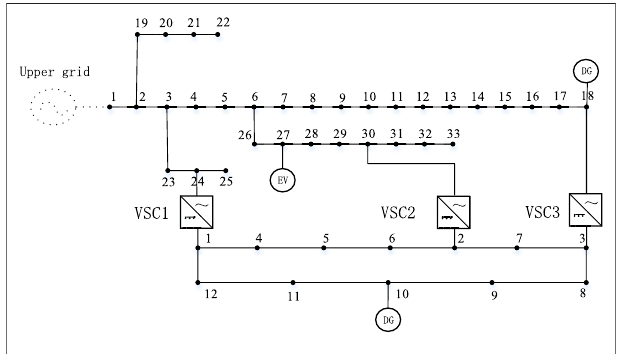
FIGURE 2 | Improved 33-node AC/DC system.